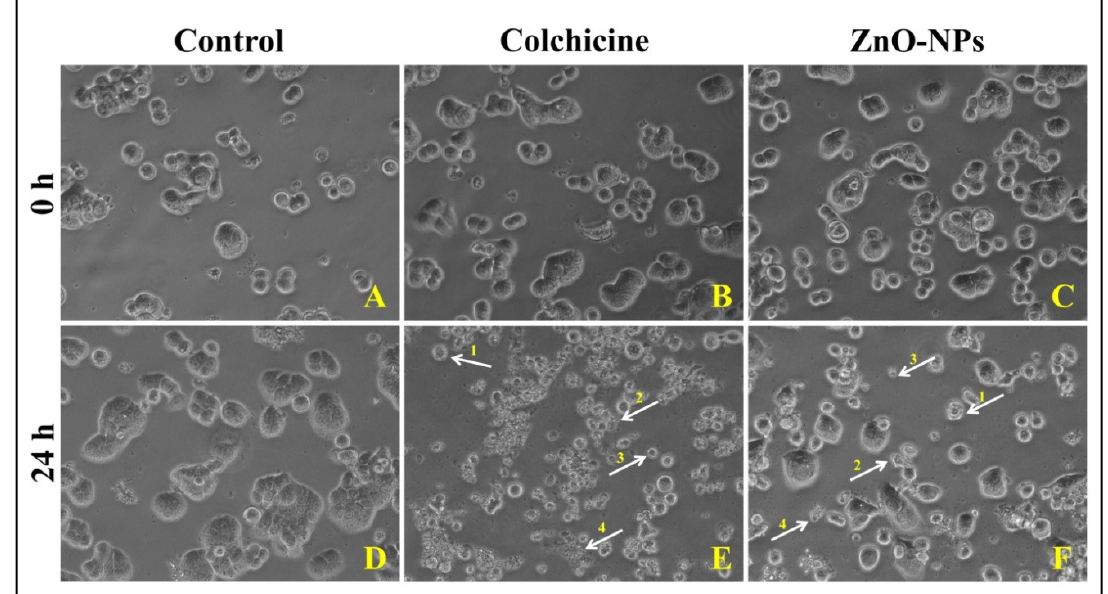
Figure 12. Representative phase-contrast inverted microscopic images showing the morphological changes observed in HT-29 cells upon treatment with phyto-fabricated ZnO-NPs. ( A , D ): Control; ( B , E ): ZnO-NPs treated; ( C , F ): Colchicine treated; 1: Membrane blebbing; 2: Nuclear fragmentation; 3: Cell shrinkage; 4: Apoptotic bodies.